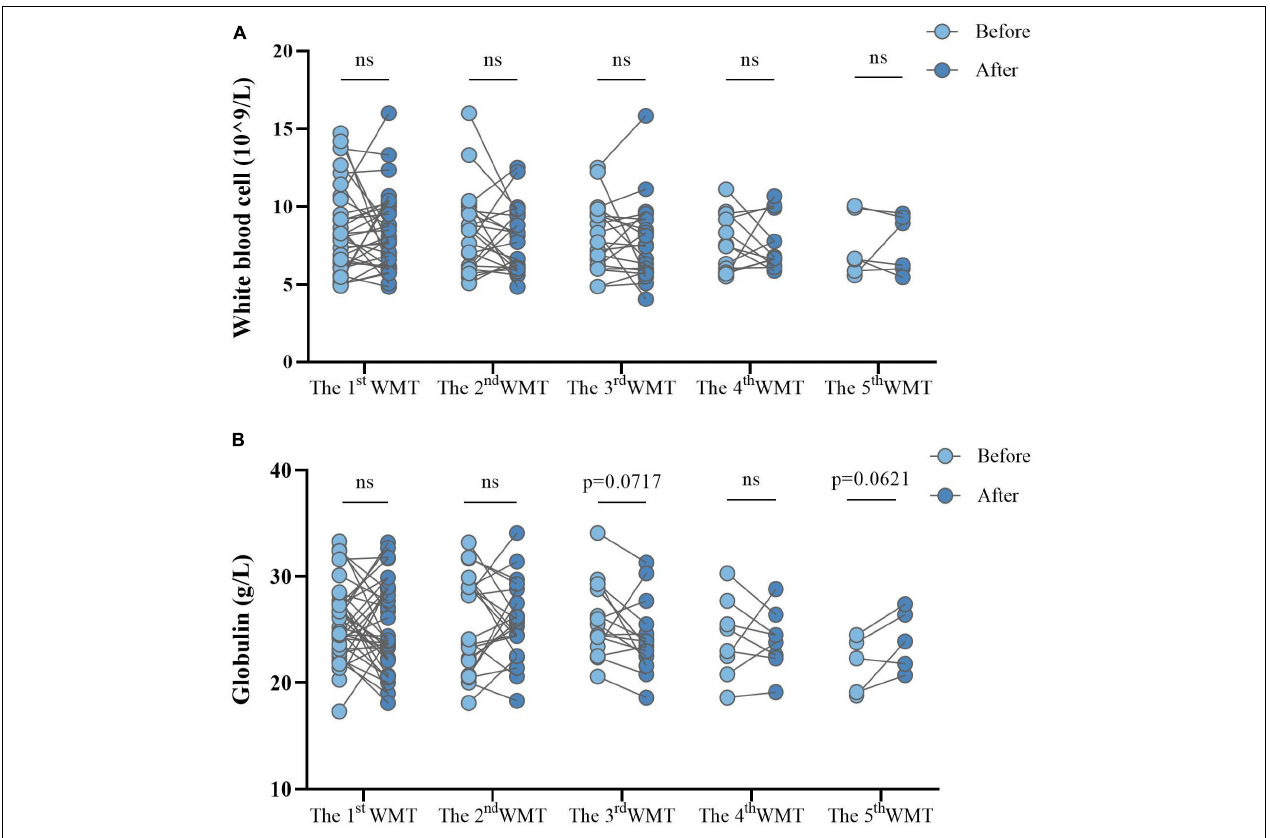
FIGURE 6 | Effect of different numbers of WMT courses on systemic inflammation measured by white blood cell counts (A) and globulin levels (B) . WMT, washed microbiota transplantation. Paired Student’s t -tests and Wilcoxon signed-rank tests were used to compare the data. ns, P > 0.05 not significant. TABLE 2 | Effect of different numbers of WMT courses on the gastrointestinal symptoms of ASD children. Baseline After 1st After 1st After 2nd After 2nd After 3rd After 3rd After 4th After 4th WMT WMT WMT WMT WMT WMT WMT